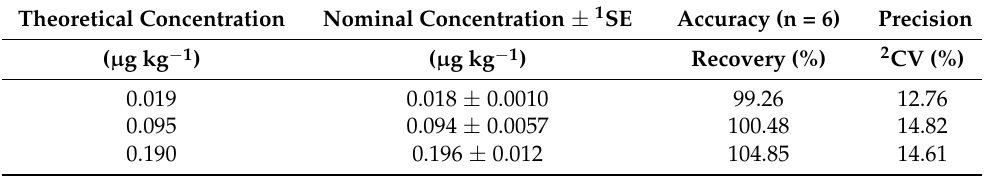
Table 3. Accuracy and precision of the headspace solid-phase microextraction method coupled with a gas chromatograph with flame ionization detector for extraction of safrole from cowpea beans. Theoretical Concentration Nominal Concentration ± 1 SE